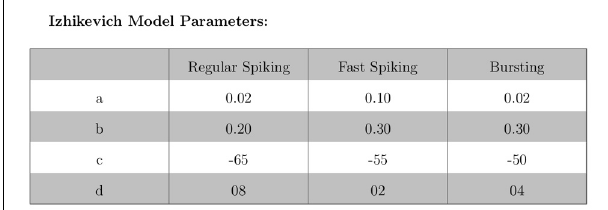
FIGURE 3 | IZH neuron model: specific values used for parameters a, b, c, and d.